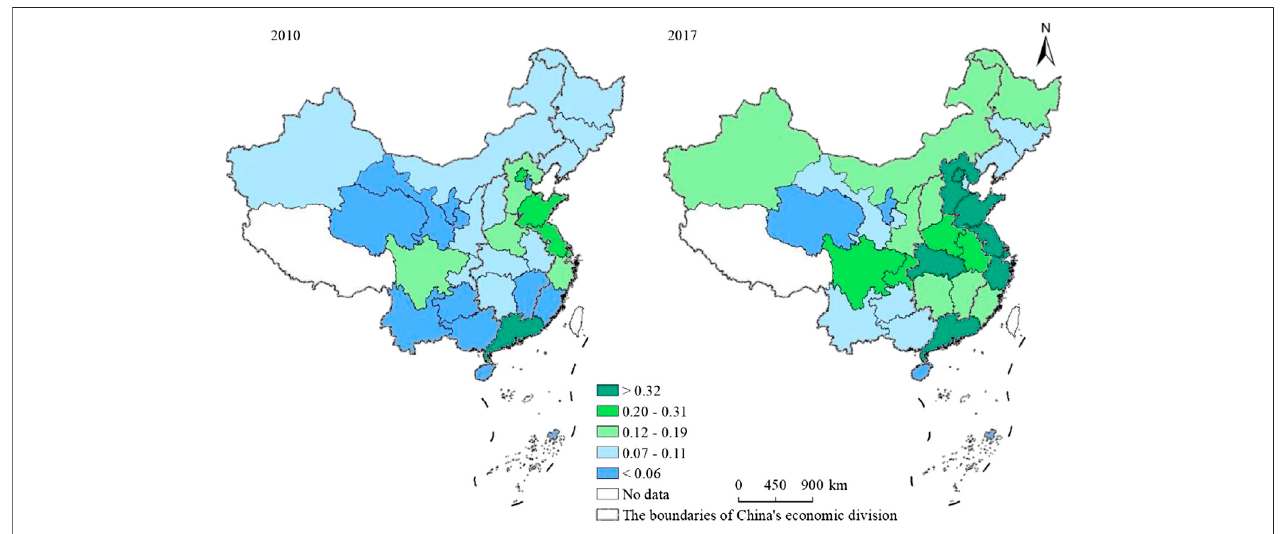
FIGURE 4 | Spatial distribution of green fi nance in 2010 and